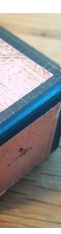
Figure 12. Smaller TactCube device for pocket